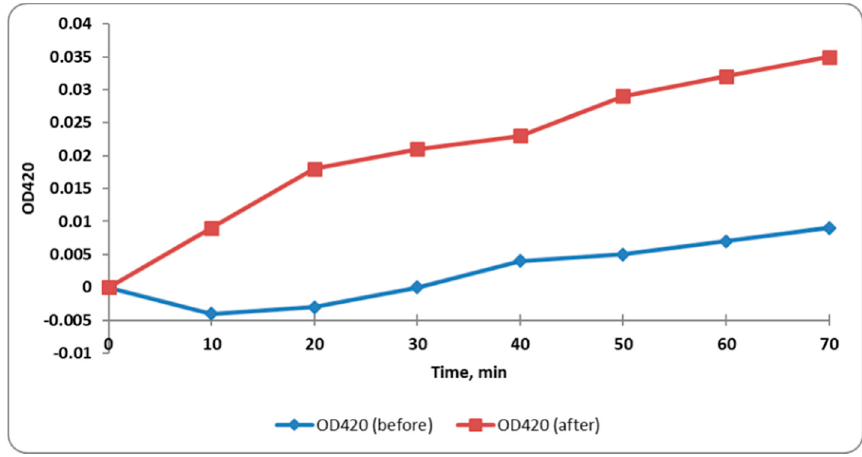
Figure 4. A chart showing the increase in the inner membrane permeability of a representative S. enterica isolate after treatment with CRME was determined by measuring the ONP absorbance with time.